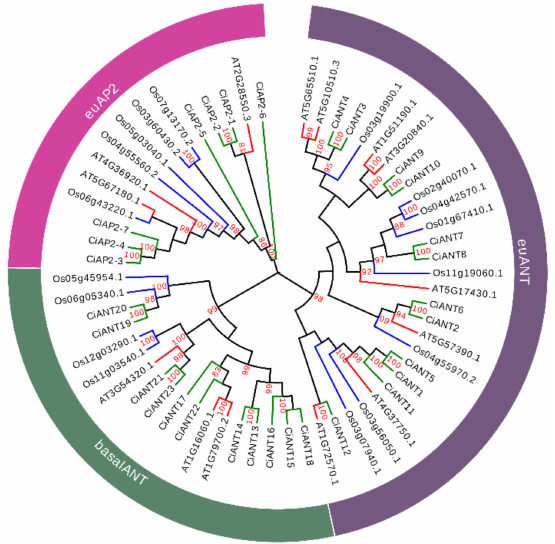
Figure 2. Phylogenetic analysis of AP2 subfamily proteins in the pecan, rice and Arabidopsis . A total of 61 AP2 proteins retrieved from pecan (30), rice (14) and Arabidopsis (17) were adopted to construct the phylogenetic tree. The tree was constructed using FastTree according to the maximum likelihood method. The AP2 subfamily proteins were clustered into three groups: euAP2, euANT and basal ANT. Proteins from pecan, rice and Arabidopsis are marked by green, blue and red colors,